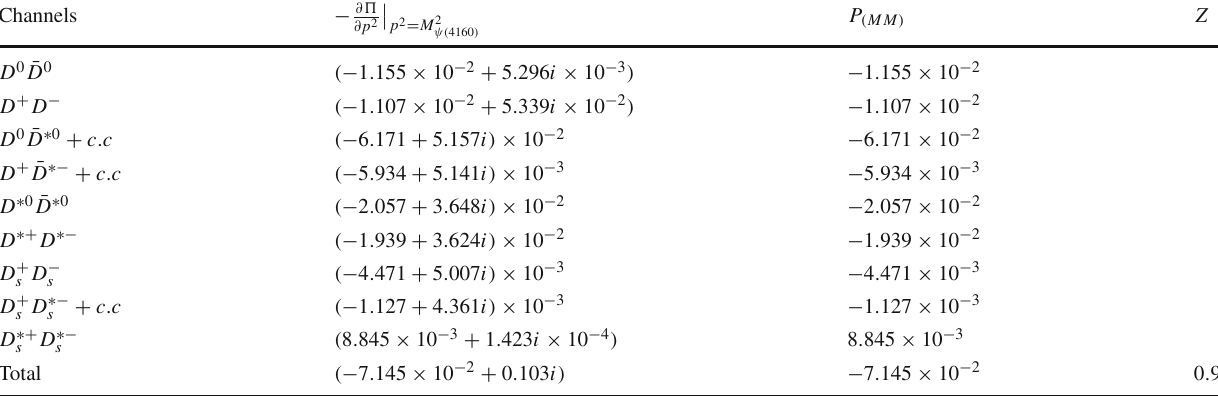
Table 5 Meson–meson probabilities in the ψ( 4160 ) wave function for Set I